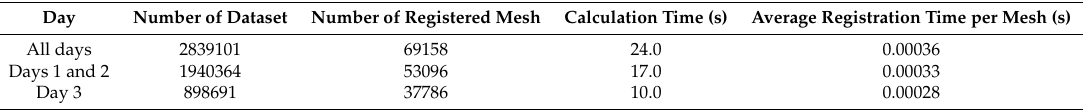
Table 6. Calculation time for statistical